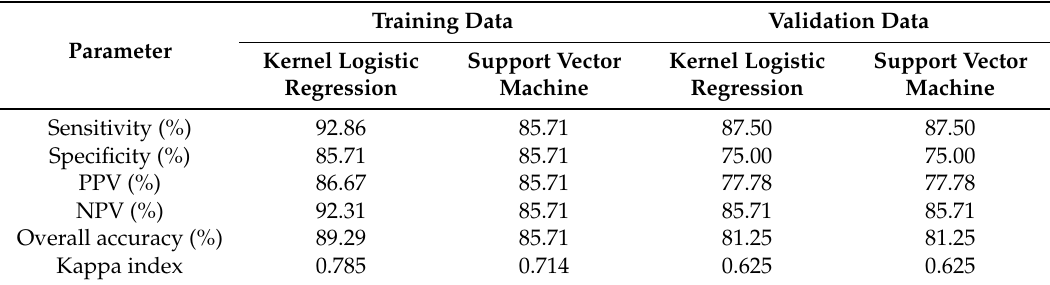
Table 2. Statistical evaluation measures of the Kernel logistic regression model and the support vector